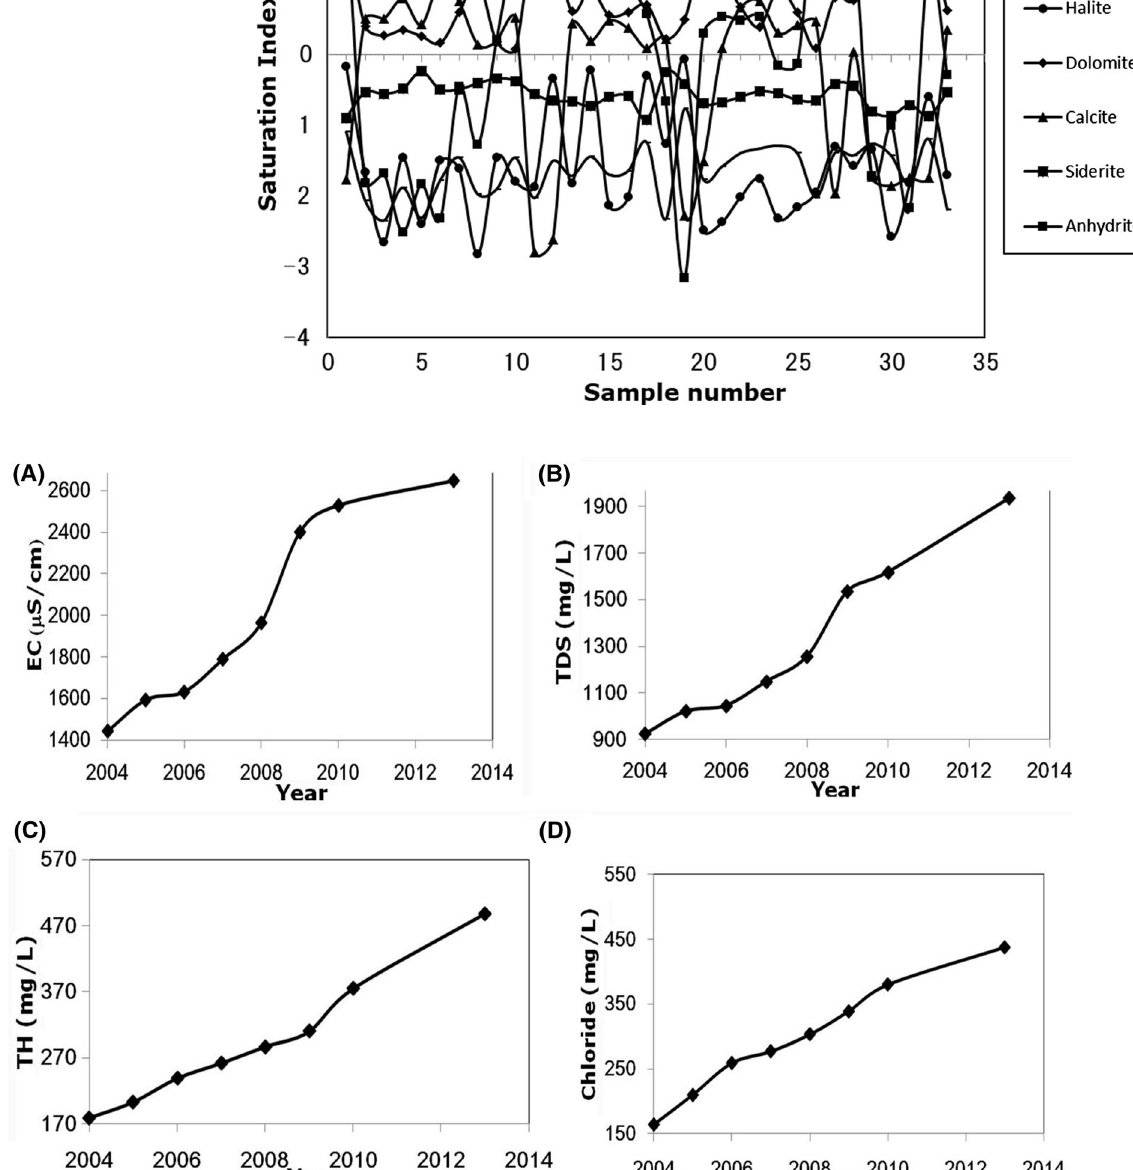
Fig. 10 Temporal variation graphs between average groundwater data parameters and time a temporal variation of year and EC, b temporal vari- ation of year and TDS, c temporal variation of year and TH and d temporal variation of year and